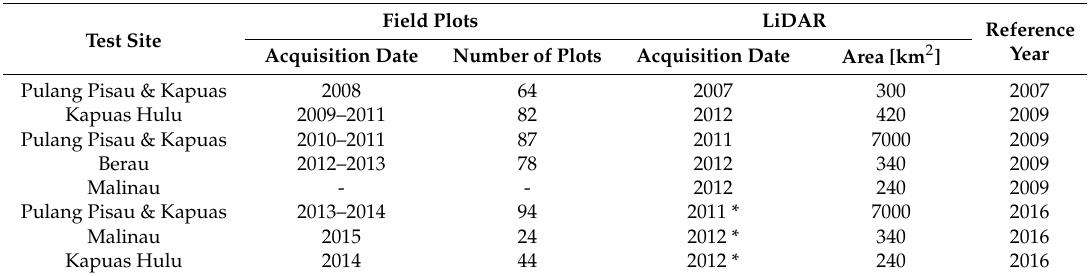
Table 1. Overview of the measured field inventory plots (473) and the acquired LiDAR data (8300 km 2 ) in Kalimantan. Field Plots Test Site